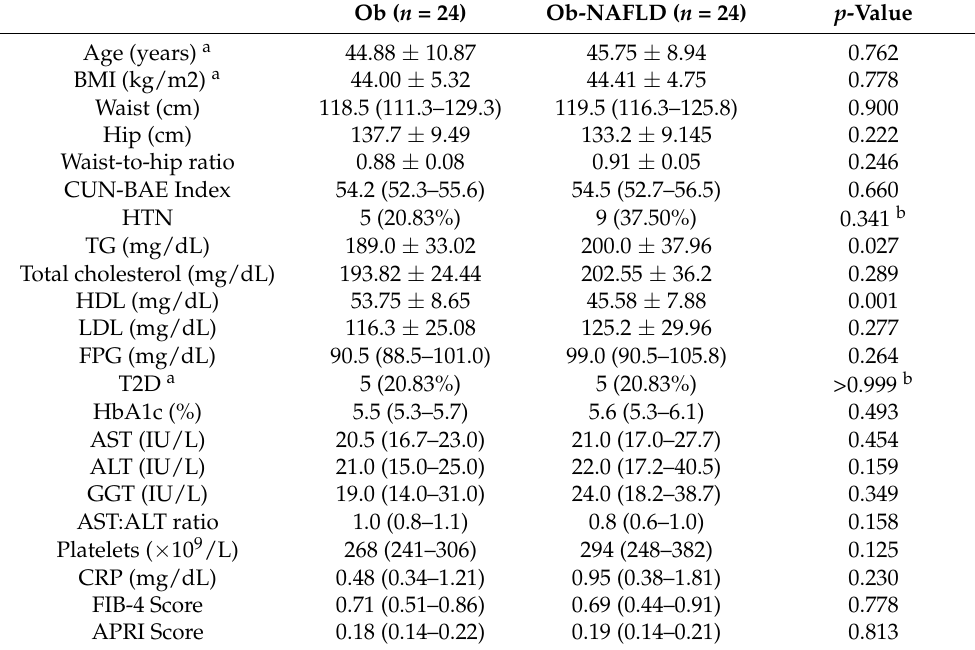
Table 1. Anthropometric and clinical characteristics of the study patients.